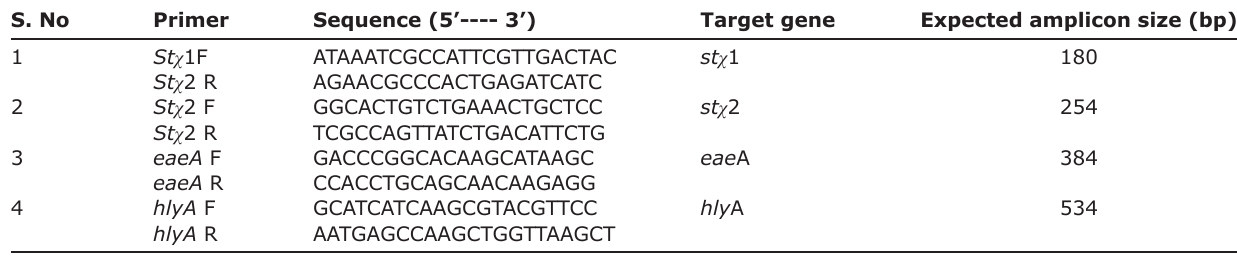
Table-1: Details of the primers used for the detection of stχ 1, stχ 2, eae A and hly A genes. S.